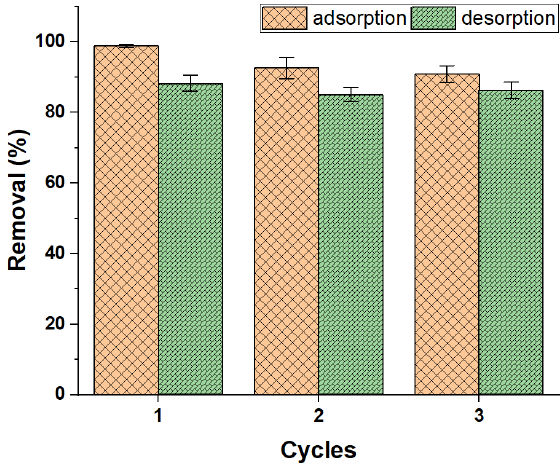
Figure 14. Adsorption efficiency of ZFAC after three cycles of operation. Bars represent the standard error of the mean ( n = 2).